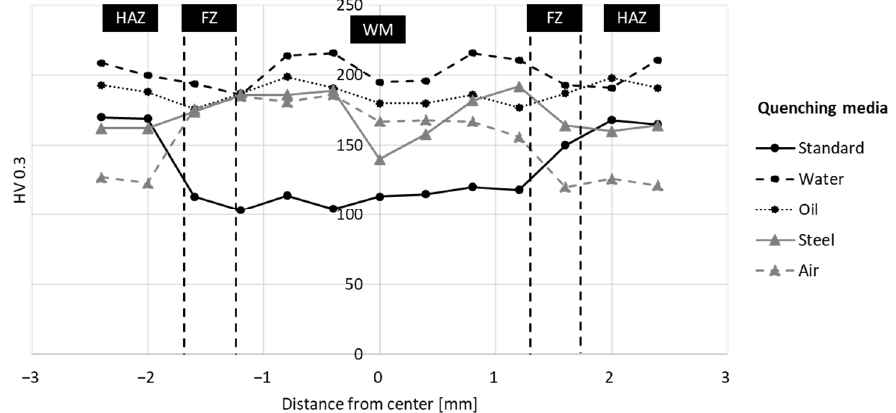
Figure 14. Hardness distribution of the welding seam. Variation of quenching media during PWHT.